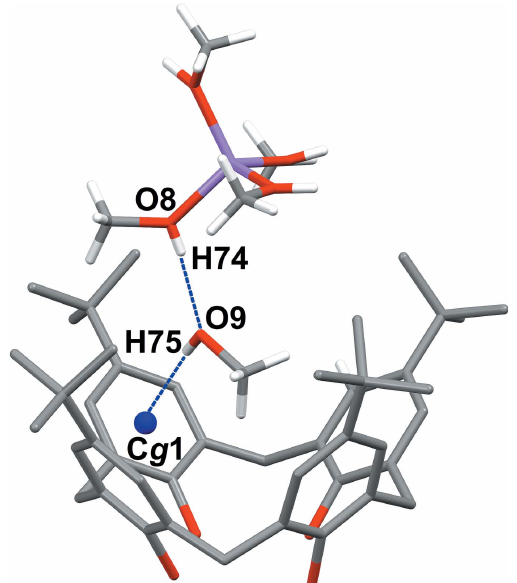
Figure 2 Hydrogen bonds (blue dotted lines) involving the p - tert -butyl- calix[4]arene anion, the methanol molecule included in the cavity, and the [Li(CH 3 OH) 4 ] + complex belonging to the asymmetric unit. The centroid of aromatic the ring, Cg 1, is represented as a blue sphere. The H atoms of the calixarene host have been omitted for